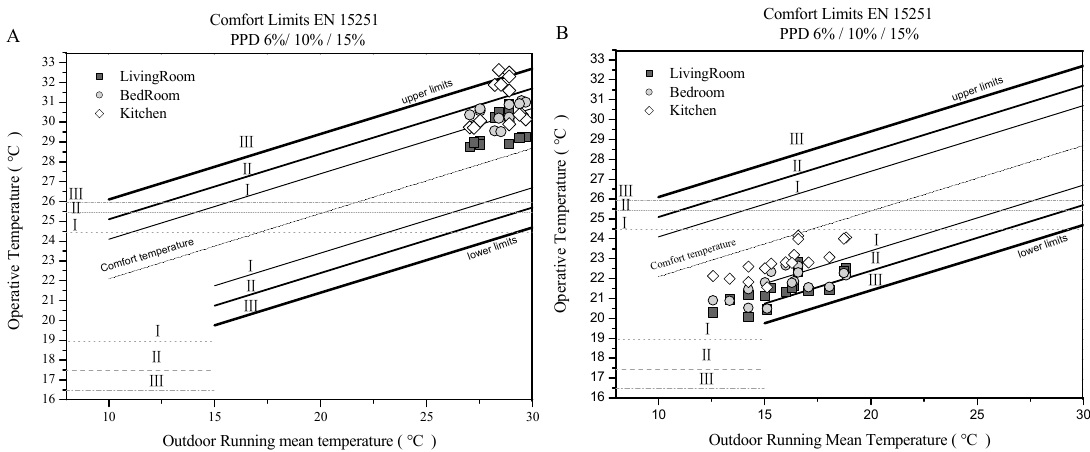
Figure 4. Operative temperatures plotted on the EN 15251 diagram during ( A ) Summer, and ( B ) Autumn (I, II, and III correspond to building categories with different thermal performance requirements).